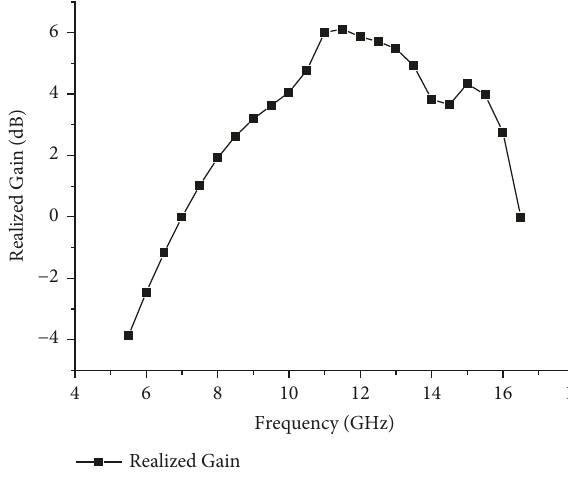
Figure 4: Return loss of the DRA element.